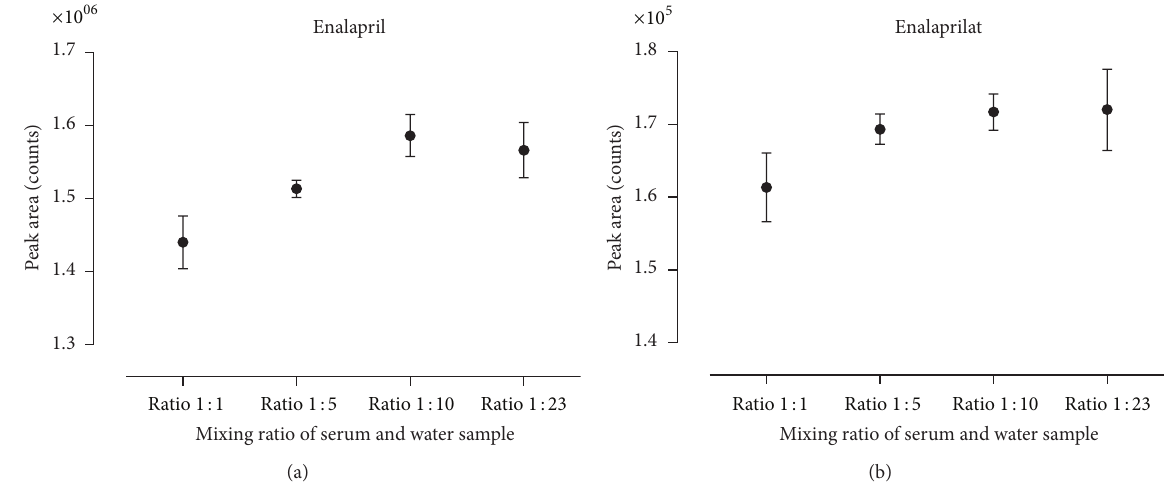
Figure 2: Comparison of mixing ratios of serum and water on resulting peak areas. The detected peak areas of enalapril (a) and enalaprilat (b) of purified serum samples are presented. The mixing ratio was varied between 1:1 and 1: 23. Each determination was conducted by three independently prepared quality control samples. The mean and corresponding standard deviations are